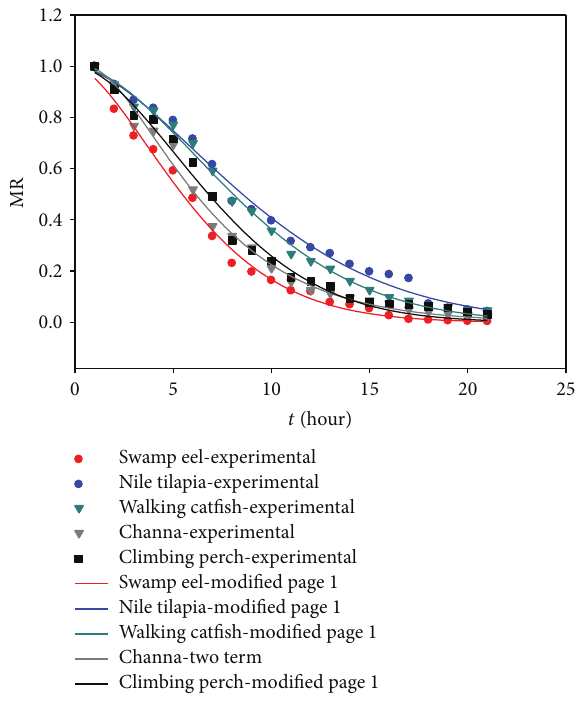
Figure 8: Experimental and predicted moisture ratio for EO drying of selected fish species.